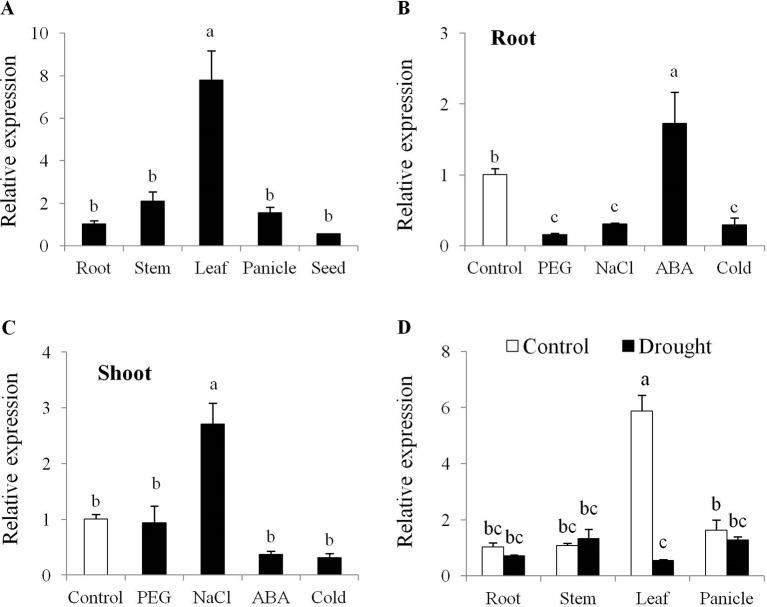
Tissue specific and stress responsive expression of OsPYL10 gene in rice cv. Nagina 22 (A)
OsPYL10 gene expression in different tissues at flowering stage under control conditions. (B–C)
OsPYL10 gene expression under different stress conditions. 14 days old Nagina 22 seedlings were treated with PEG6000 (20%), NaCl (200 mM), ABA (100 µM) and cold (4°C) for 6 hours and expression of OsPYL10 gene was analyzed in root (B) and shoot (C) tissues. (D)
OsPYL10 gene expression in different tissues at flowering stage under control and drought conditions in the field. Sample were collected for RNA isolation from field under control and drought (-80kPa; Soil moisture content = 7.6%) conditions. Value shown in graph are mean of three biological replicate (n = 3). Error bar indicates ±SE. Statistical differences are shown on the bars by labelling significantly different groups with different letters.